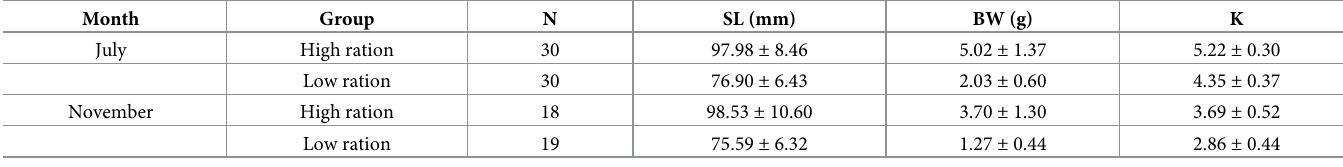
Table 1. Standard length (SL), body weight (BW), and Fulton’s condition factor (K) of western sand lance ( Ammodytes japonicus ) in July (July 14) and November (November 16 and 30) in Experiment II.